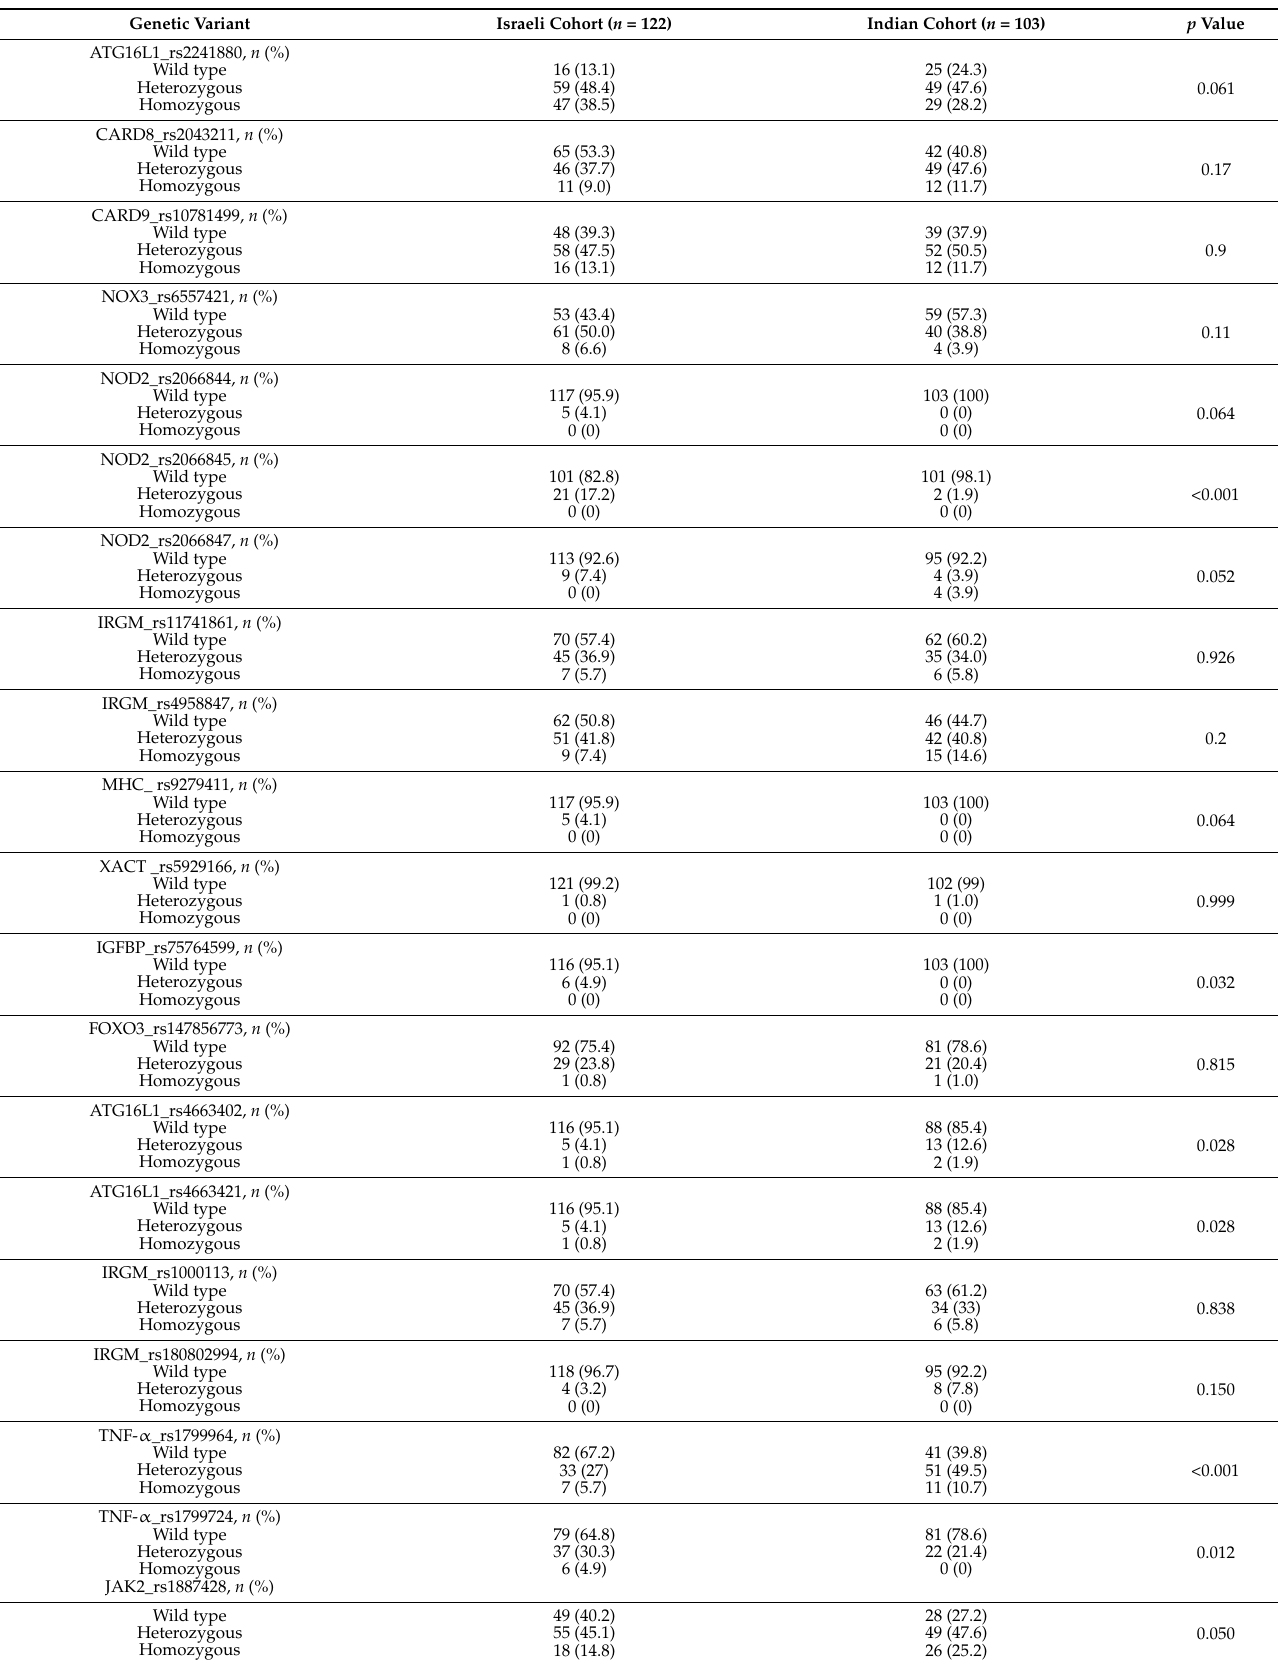
Table 3. Susceptible genes variation in Indian and Israeli